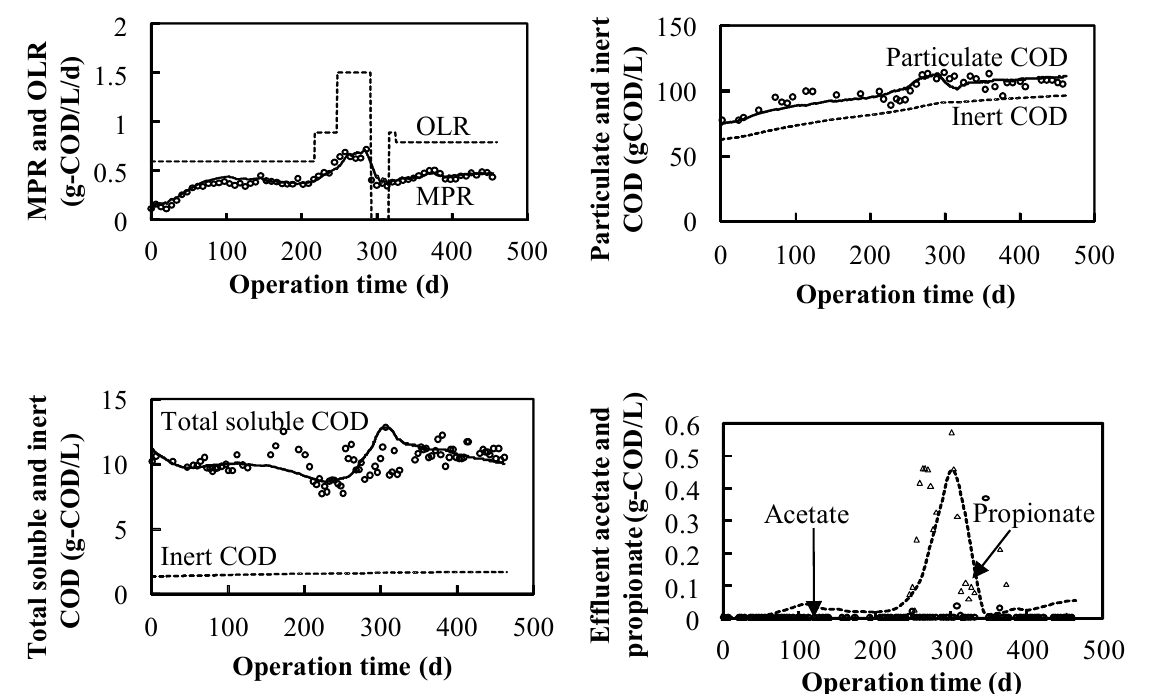
Figure 4. Measured and simulated results of MPR, VFAs, and particulate/soluble COD in the NaCl system.